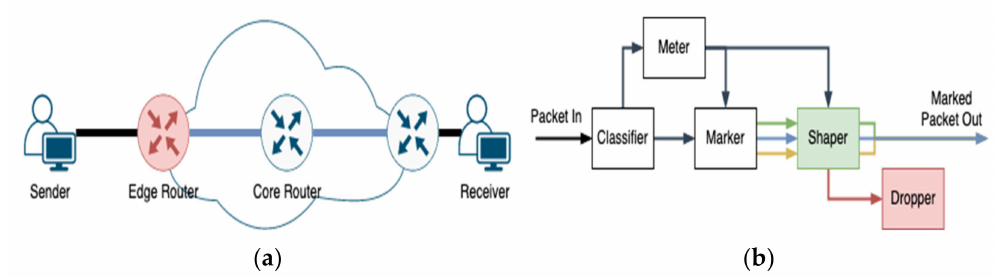
Figure 3. DiffServ operation architecture ( a ) Architecture diagram ( b ) Operation process.